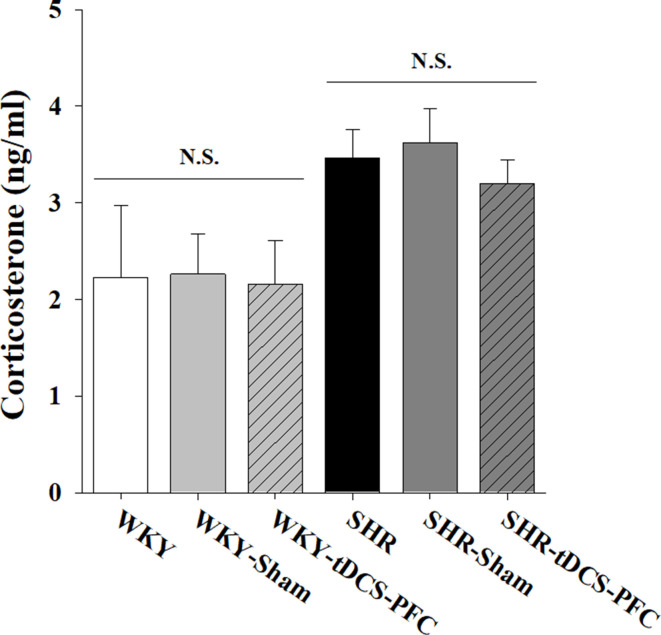
Effect of HD-tDCS application over the prefrontal cortex on corticosterone levels in the plasma of our ADHD rat model and its control strain at 2 days after the last HD-tDCS application.Free corticosterone levels were measured by ELISA (n = 5). HD-tDCS application did not induce any changes in corticosterone levels in the plasma. Data are presented as the mean ± SEM.